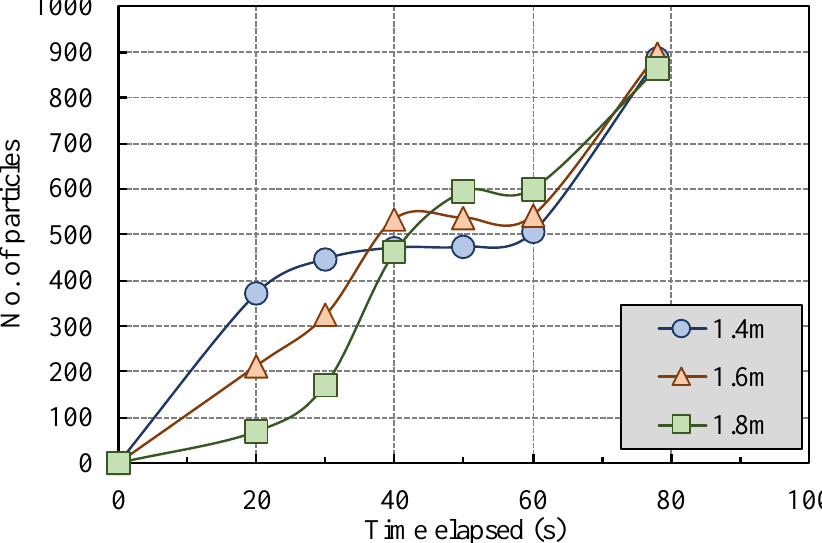
Figure 9. Total mud discharge particles for each probe region.